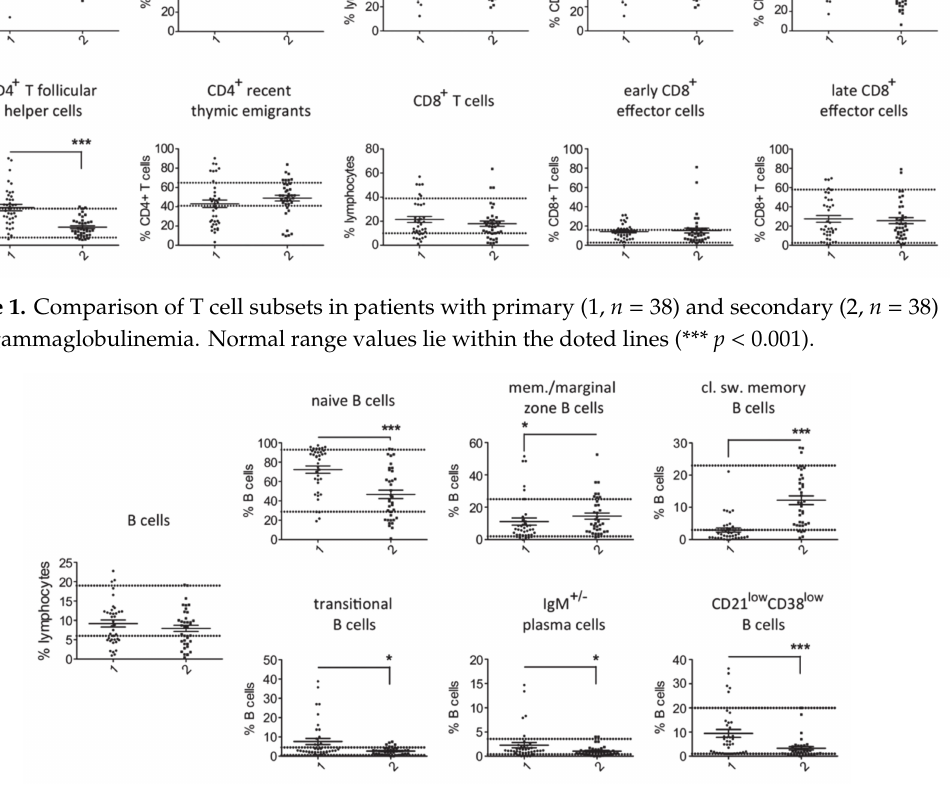
Figure 2. Comparison of B cell subsets in patients with primary (1, n = 38) and secondary (2, n = 37) hypogammaglobulinemia. Normal range values lie within the doted lines (* p < 0.05; *** p <